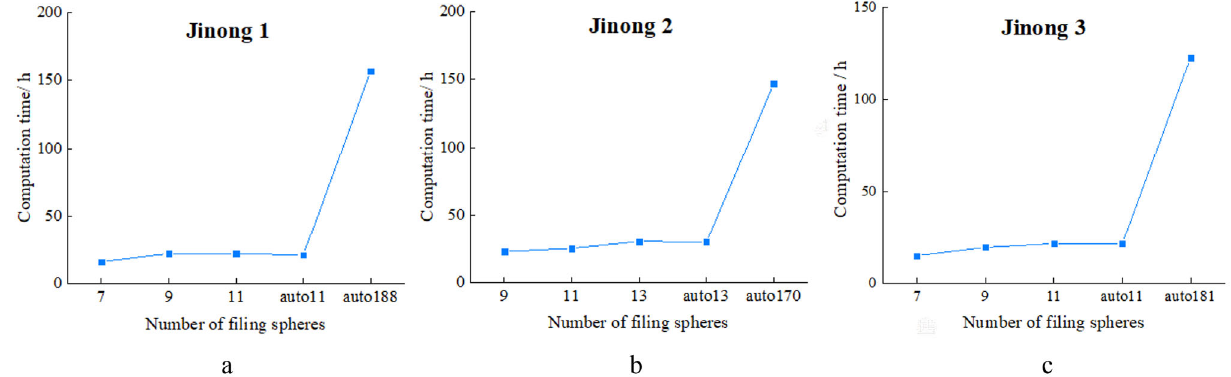
Figure 17. Computational times of the piling test simulation.